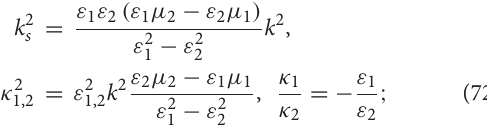
Here, A s is the coordinate-independent